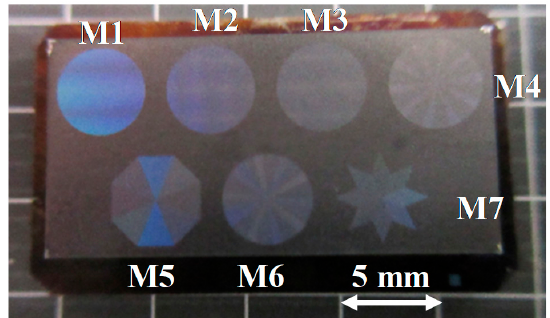
Figure 4. Seven microtexture patterns directly printed onto the nitrided AISI316 die surface.